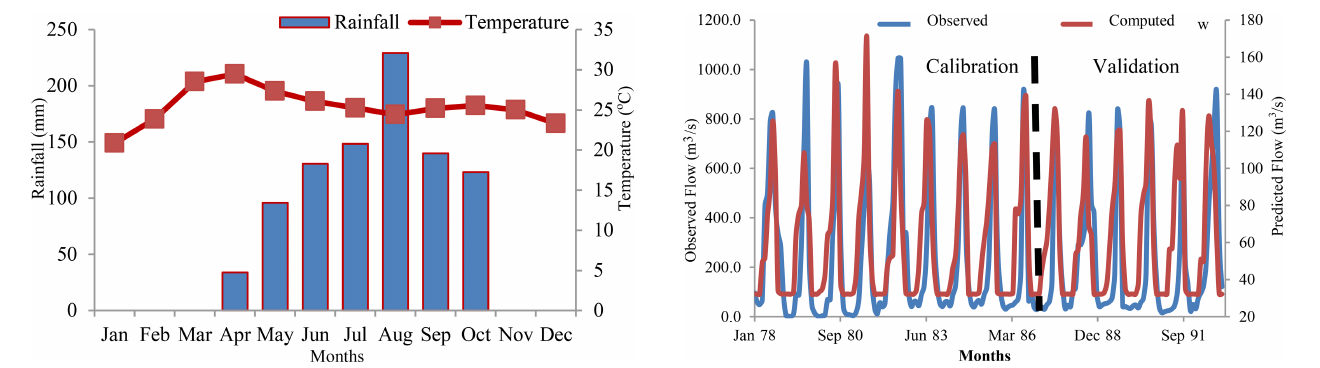
Figure 5. Computed runoff fit on the observed runoff for the period 1978 to